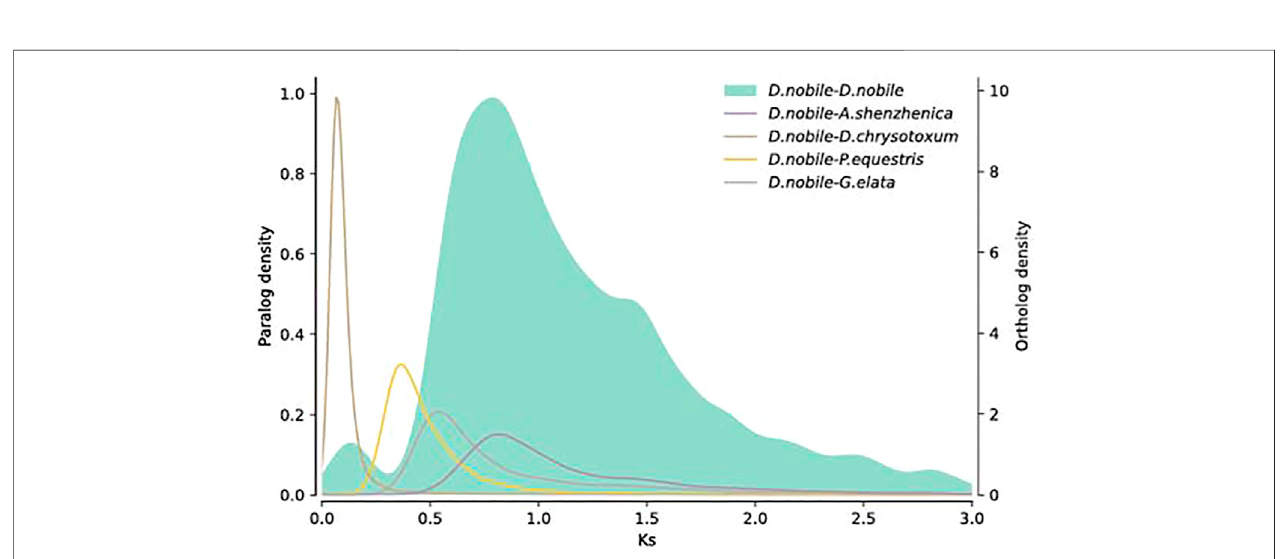
FIGURE 6 | Distribution of Ks of the whole paranome of Dendrobium nobile . The Ks distribution of paralogues in the D. nobile genome is shown in the gray histogram and gray density curve. The other density curves show the Ks distribution of orthologous genes between D. nobile and Phalaenopsis equestris , D. nobile and Apostasia shenzhenica , D. nobile and Dendrobium chrysotoxum , and D. nobile , and Gastrodia elata .